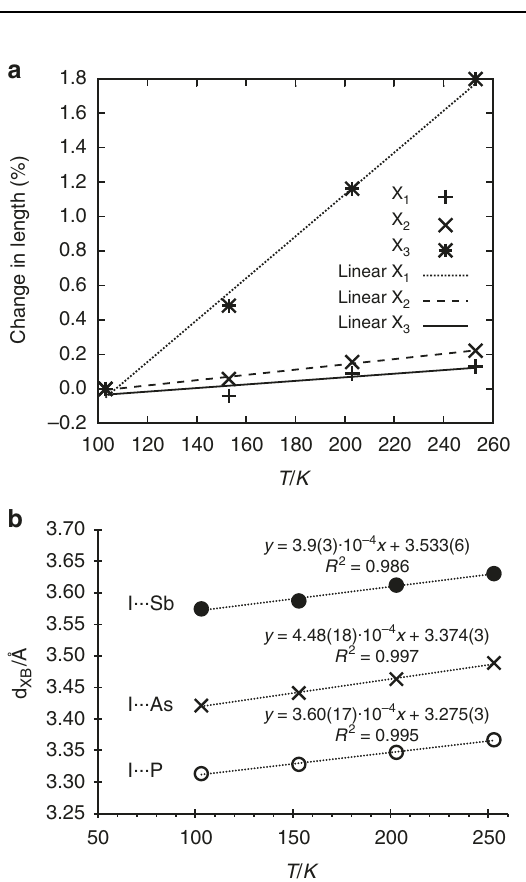
Fig. 5 Selected thermal properties of the herein presented cocrystals. a Temperature dependence of the principal axes lengths reveals colossal thermal expansion for ( tftib )( SbPh 3 ). For corresponding data on ( tftib ) ( PPh 3 ) and ( tftib )( AsPh 3 ) see Supplementary Figs. 27-29. b Temperature- dependent change in d XB for ( tftib )( PPh 3 ) (bottom), ( tftib )( AsPh 3 ) (middle), and ( tftib )( SbPh 3 )